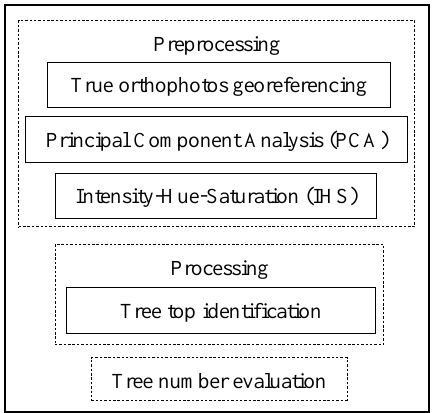
Figure 4. Flowchart of the overall